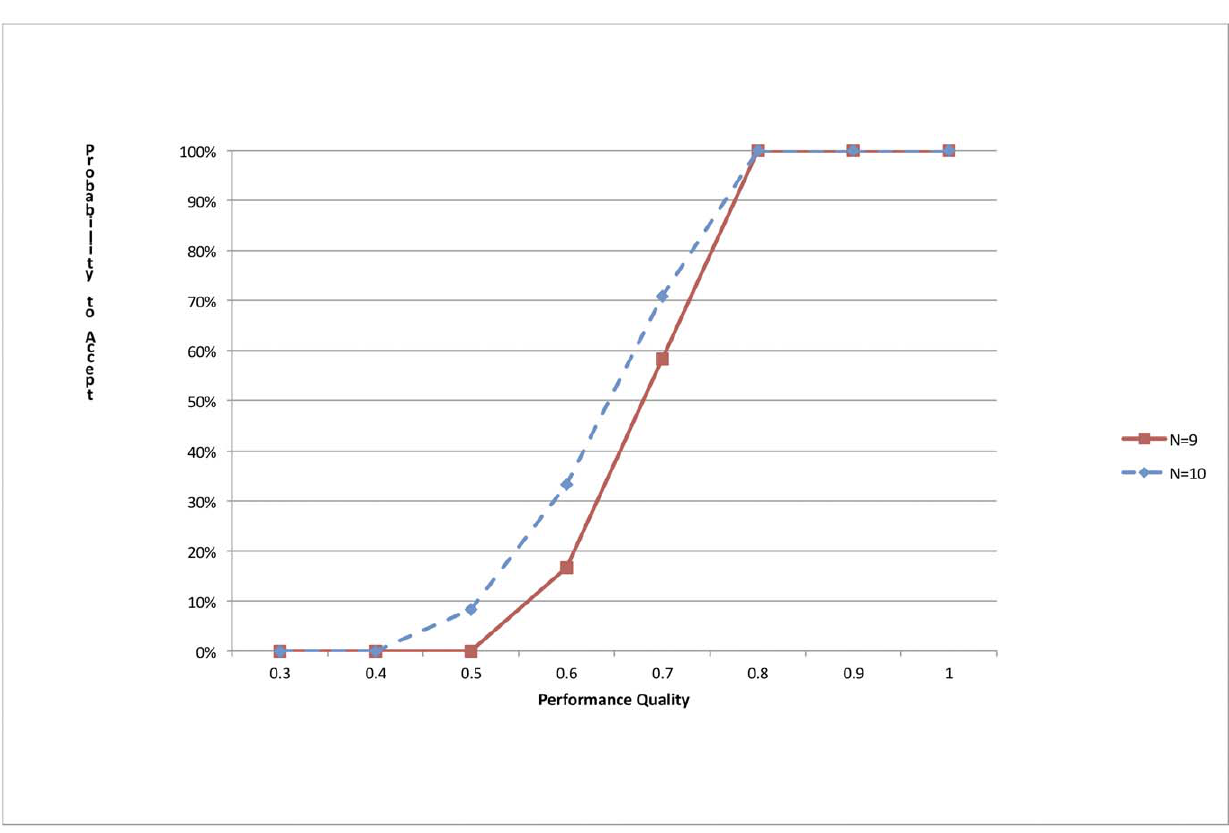
Figure 1. Operating Characteristic Curve for Health Facility Assessments with n=7 and a Decision Rule of 5 for P U =80% and P L =50% for areas with a total of 9 and 10 health facilities. doi:10.1371/journal.pone.0044319.g001 PLOS ONE |